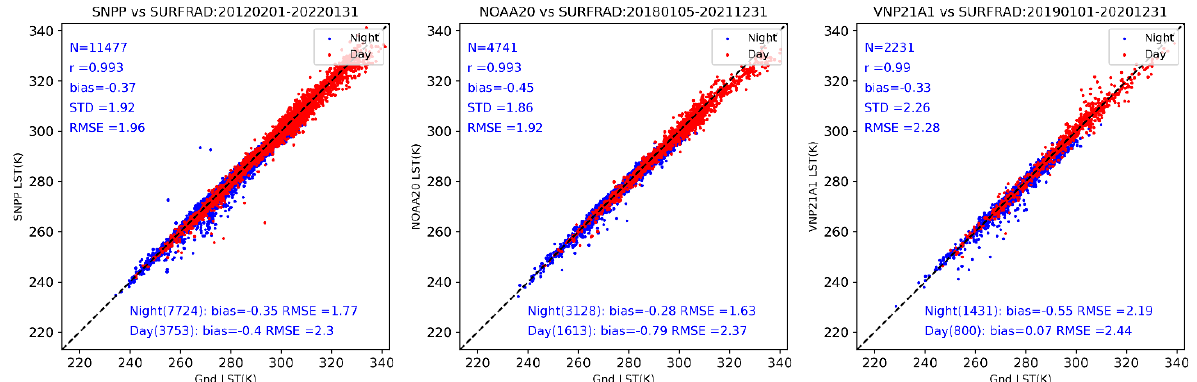
Figure 1. The overall VIIRS LST validation against SURFRAD observations for SNPP ( left ), NOAA- 20 ( middle ) and VNP21A1 ( right , two years of data in 2019 and 2020 were used). The nighttime comparison result shows a bias of − 0.35 K, − 0.28 K, and − 0.55 K, a RMSE of 1.77 K, 1.63 K, and 2.19 K, the daytime result shows a bias of − 0.4 K, − 0.79 K, and 0.07 K with a RSME of 2.3 K, 2.37 K, and 2.44 K for SNPP, NOAA-20, and VNP21A1 LST,